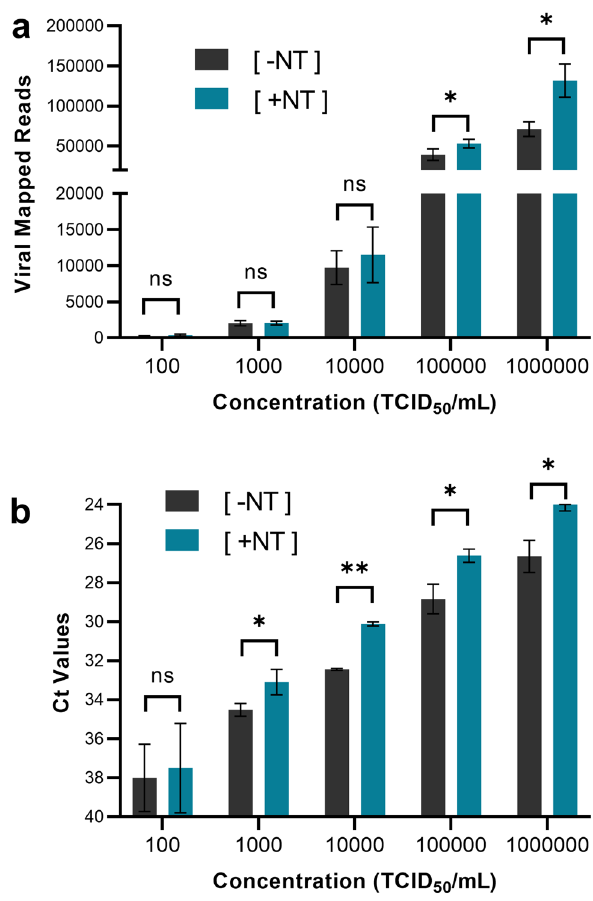
Figure 2. Magnetic Hydrogel Particles (Nanotrap Particle Workflow 2) Improves Sequencing of Contrived SARS-CoV-2 Samples. Heat inactivated SARS-CoV-2 was spiked into VTM at 10 2 , 10 3 , 10 4 , 10 5 , and 10 6 TCID 50 / mL and samples were processed using Nanotrap Particle Workflow 2 [+ NT] or the MagMAX Kit alone [− NT]; n = 3 for each process. Samples then underwent sequencing on a ONT MinION R.9 flow cell ( a ) or RT-PCR ( b ). [+ NT] were compared to [− NT] by paired t -test in order to assess significance of increased viral detection. * p < 0.05, ** p <